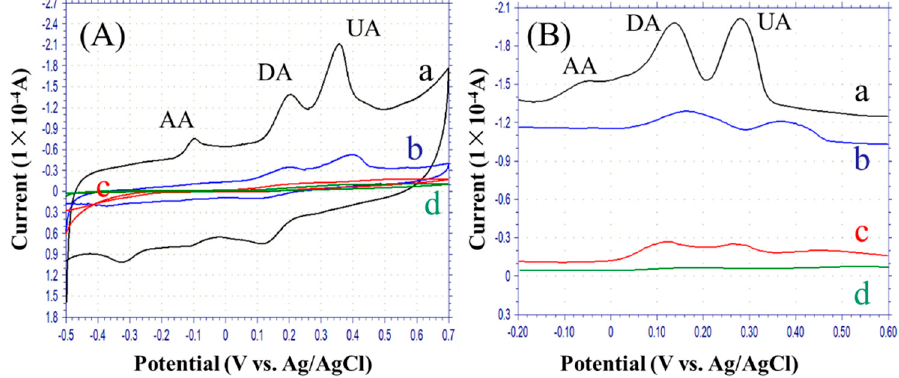
Figure 2. ( A ) Cyclic voltammetry (CV) responses of ternary mixture of 1.0 mM ascorbic acid (AA), 1.0 mM dopamine (DA), and 1.0 mM uric acid (UA) in 0.1 M phosphate buffer solution (PBS) (pH 7.0) on CB-CNT/PI/GCE (a), CB/PI/GCE (b), CNT/PI/GCE (c), and PI/GCE (d) at 5 mV/s; ( B ) differential pulse voltammetry (DPV) responses of ternary mixture of 1.0 mM AA, 1.0 mM DA, and 1.0 mM UA in 0.1 M PBS (pH 7.0) on CB-CNT/PI/GCE (a), CB/PI/GCE (b), CNT/PI/GCE (c), and PI/GCE (d) at 5 mV/s.